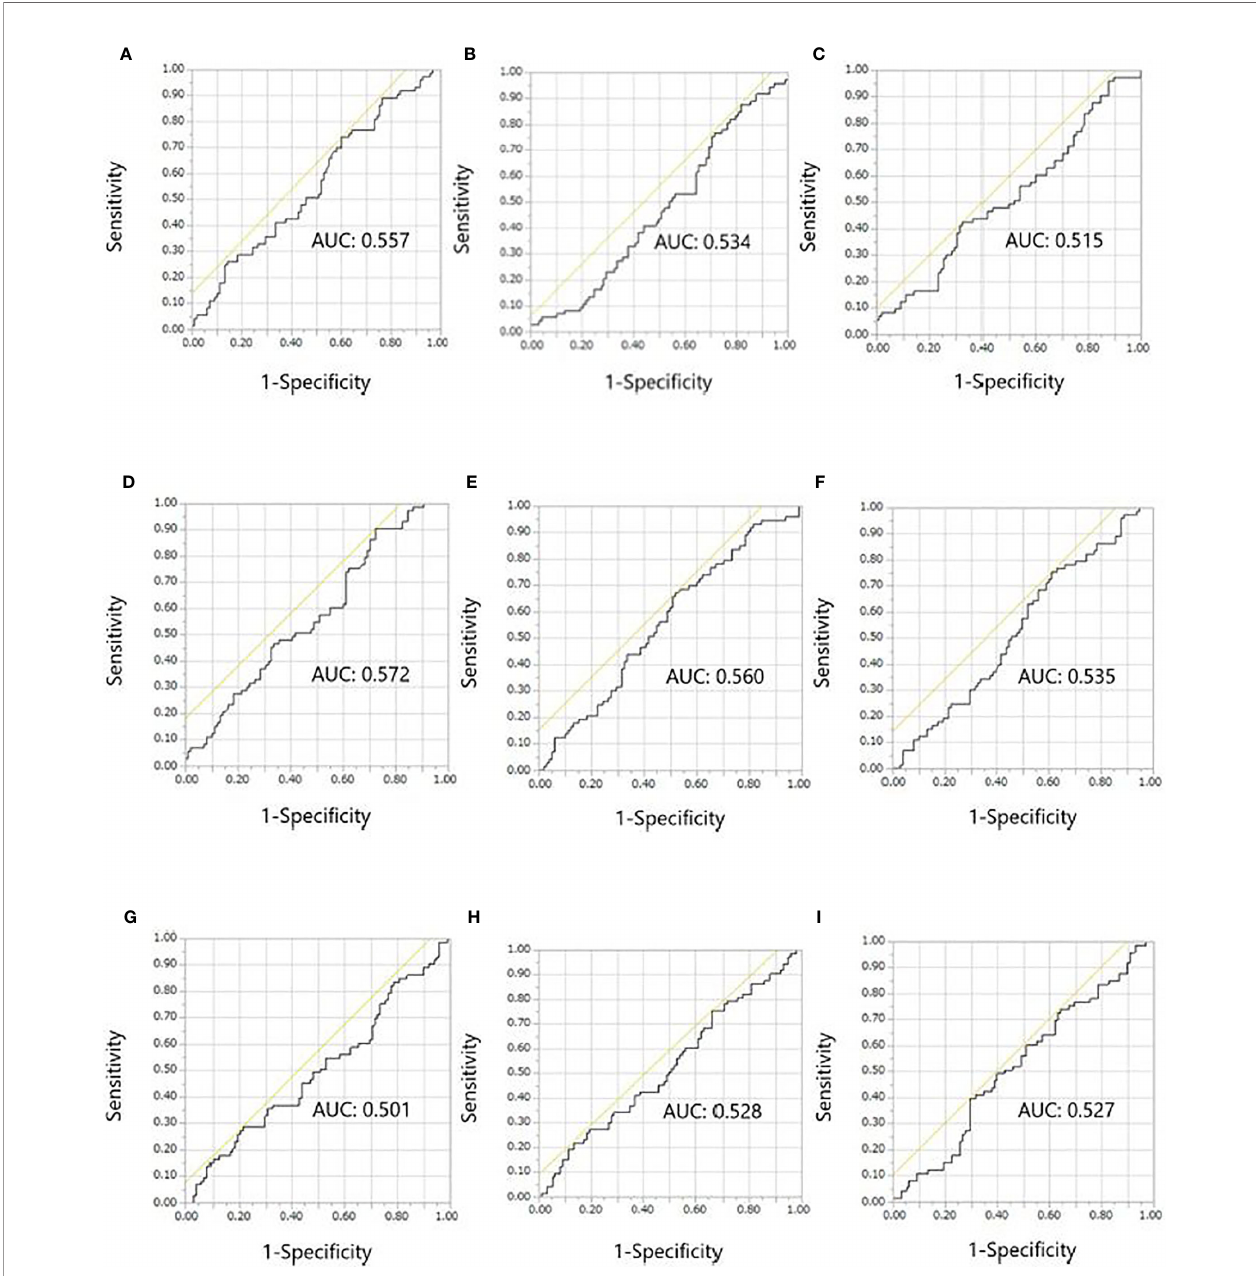
FIGURE 2 | Receiver operating characteristic curves for the early onset of any immune-related adverse event. (A) ALC, (B) NLR, and (C) LMR at baseline. (D) ALC, (E) NLR, and (F) LMR at 2 weeks after treatment initiation. (G) ALC, (H) NLR, and (I) LMR at 2 weeks/baseline. ALC, absolute lymphocyte count; AUC, areas under the curve; LMR, lymphocyte-to-monocyte ratio; NLR, neutrophil-to-lymphocyte